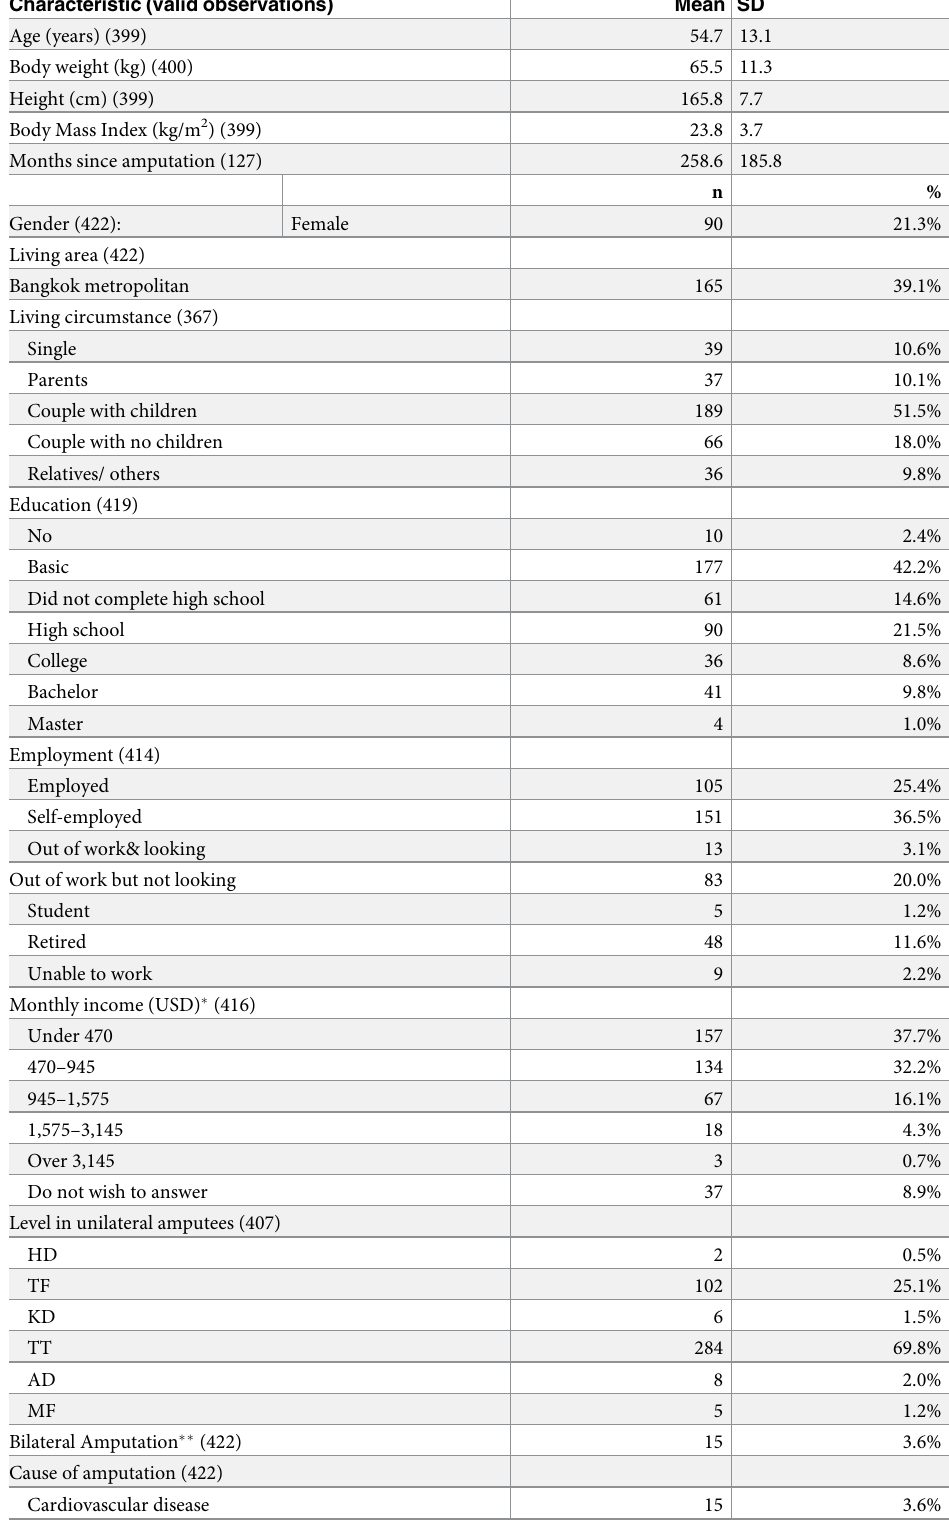
Table 1. Participant characteristics (n =